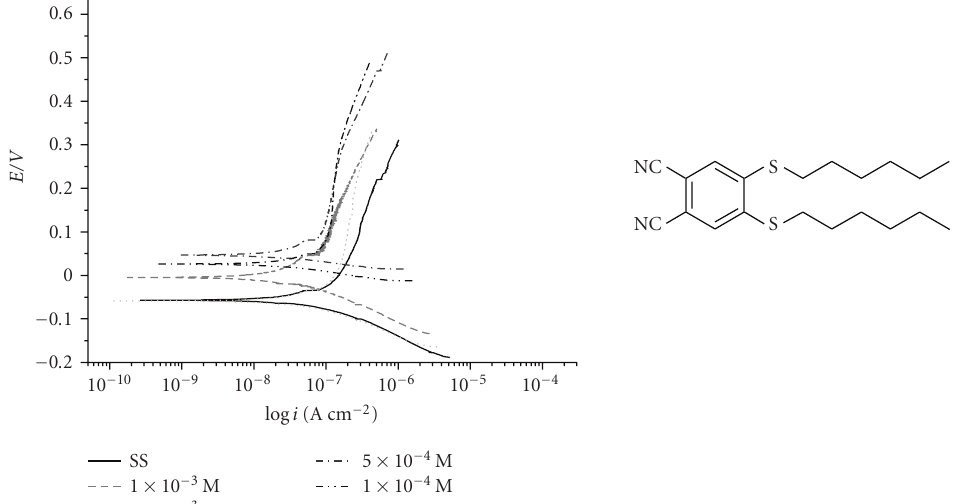
Figure 2: Polarizationcurves of stainlesssteel in the presence and absence of di ff erent concentrationsof 4,5-bis(hexylsulfonyl)-phthalonitrile (Bis-HSPN) in 3.0M NaCl medium.